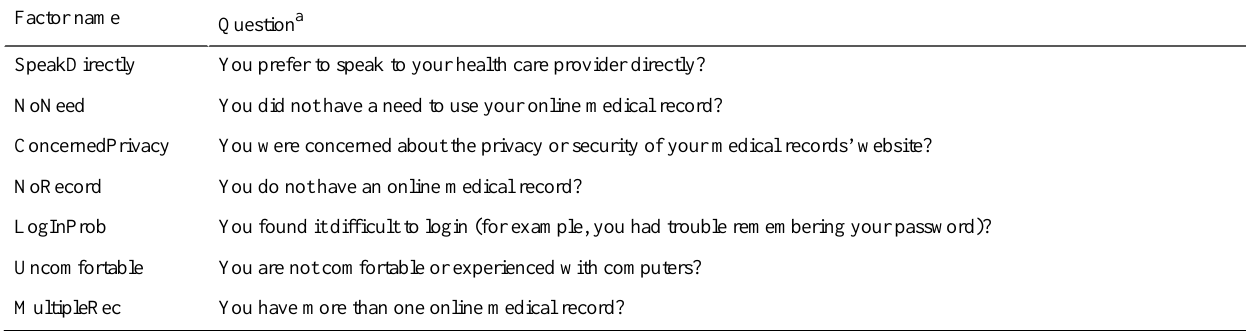
Table 1. Questions for nonusers and corresponding